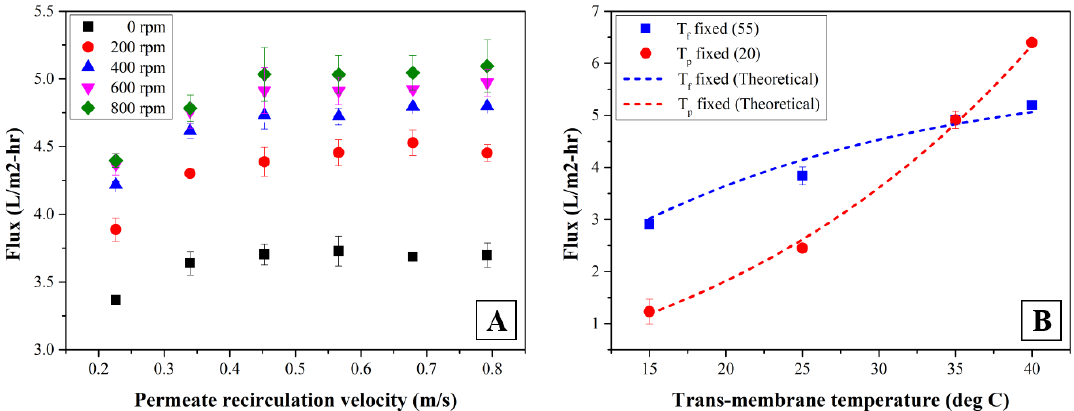
Figure 2. Permeate flux changes with operational parameters ( A ) permeate recirculation velocity and mixing intensity, ( B ) trans-membrane temperature.